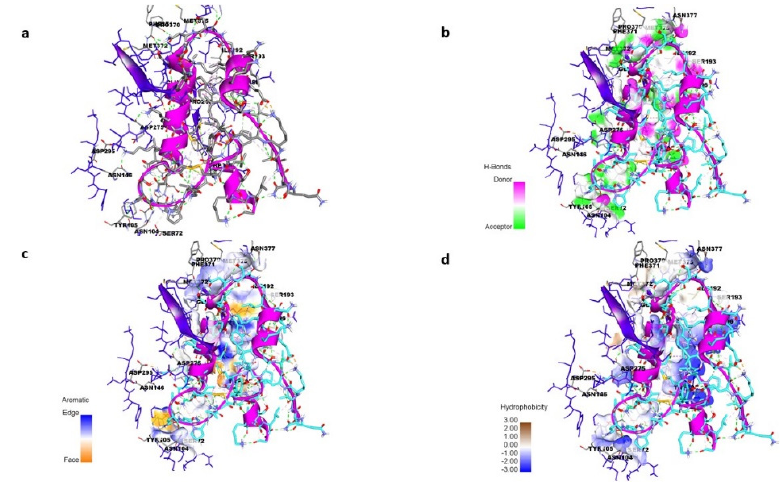
Figure 11. ( a ) Mode of binding of EntP (indigo) peptide with protein stabilized by non-bonding interactions with amino acid residues. ( b ) Hydrogen-bonding interactions of peptide with protein residues. ( c ) Representation of π – π interaction stabilizing the binding of EntP. ( d ) Hydrophobic cavity supporting peptide binding to protein.